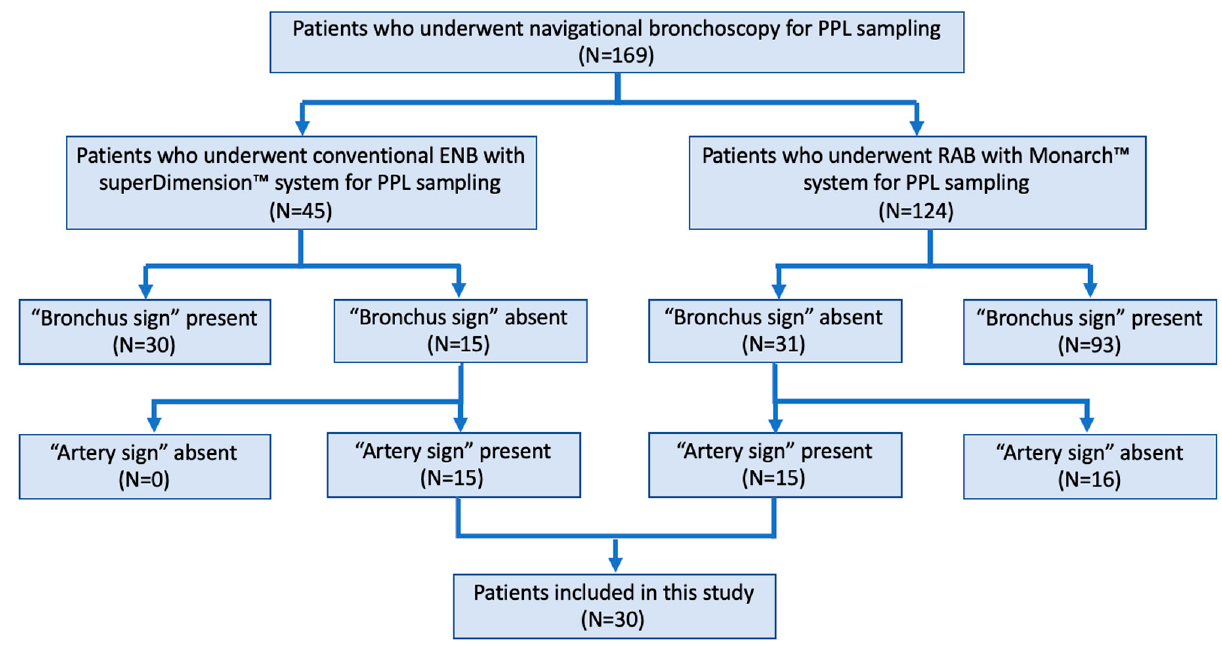
Figure 1. Flow diagram depicting how patients were selected for study inclusion. PPL = parenchymal pulmonary lesion; ENB = electromagnetic navigation bronchoscopy; RAB = robotic- assisted bronchoscopy. In patients with “bronchus sign” present, the presence of the “artery sign” was not evaluated since the planning software and algorithm are based on airway segmentation, and therefore the presence of the “artery sign” does not impact the workflow of the procedure.